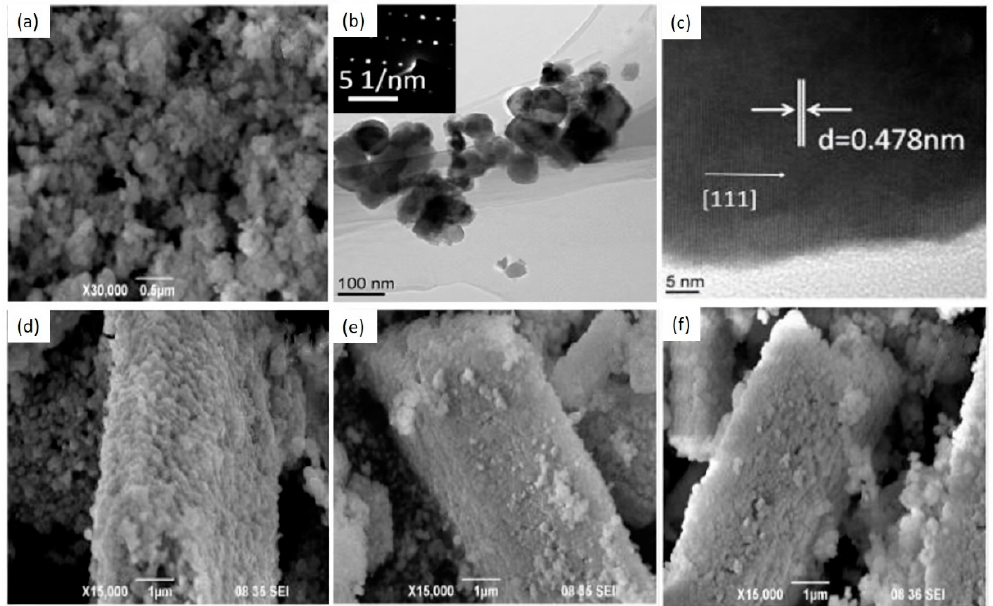
Figure 5. SEM and TEM images of ZnGa 2 O 4 crystallites were prepared at different thermal hydrothermal temperatures. ( a ) SEM image of ZnGa 2 O 4 crystallites prepared at 160 °C, ( b ) TEM image of ZnGa 2 O 4 powders obtained at 160 °C. The inset shows the SAED pattern from individual ZnGa 2 O 4 spherical particle. ( c ) The HRTEM picture of ZnGa 2 O 4 crystallites obtained at 160 °C, ( d – f ) SEM images of ZnGa 2 O 4 crystallites obtained at 170, 180 and 200 °C [68] (with copyright permission from Elsevier, 2020).